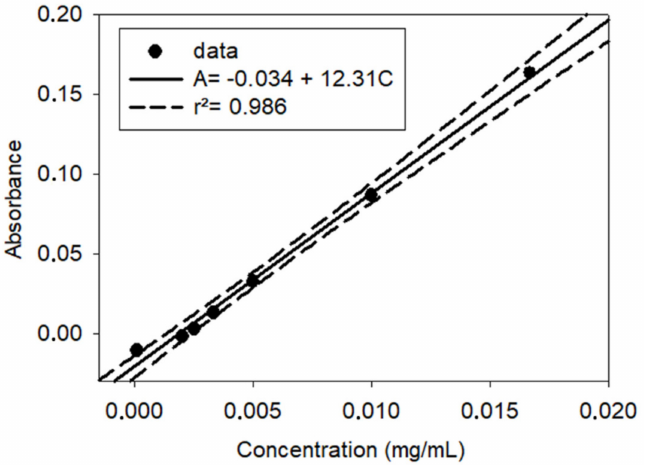
Figure 2. The calibration curve for pyrogallol at 267 nm (r 2 =